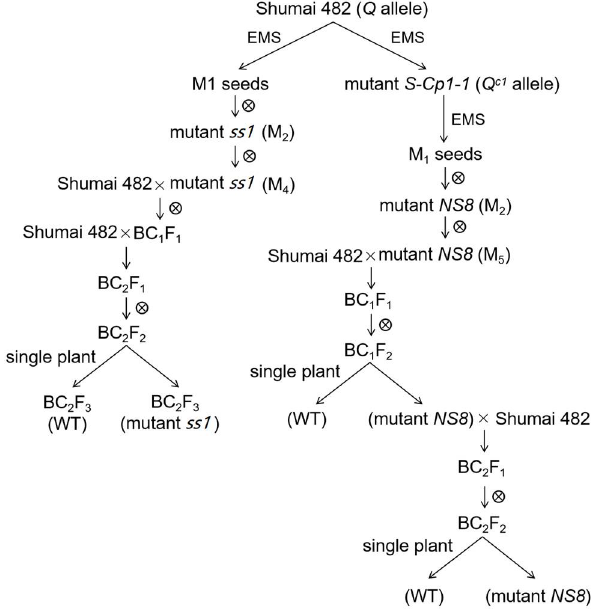
Figure 1. Outline of the generation of the mutants ss1 and NS 8 in the T. aestivum cv. ‘Shumai 482′ genetic background.